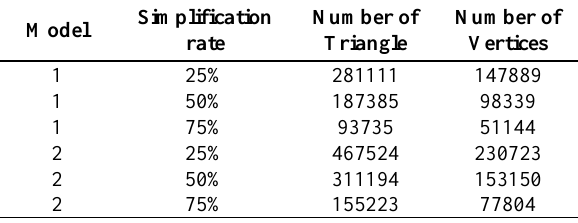
Table 1 . Statistics of model simplification results.